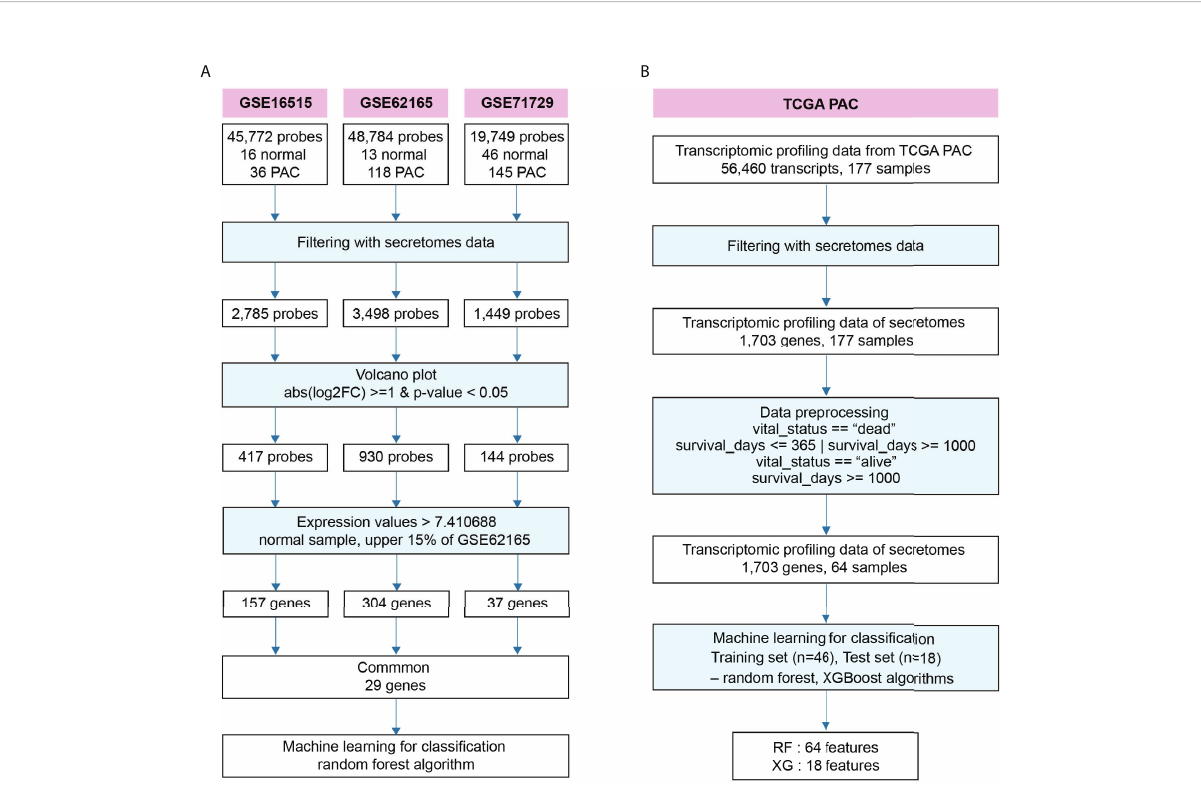
FIGURE 1 Schematic work fl ow to identify diagnostic and prognostic markers for pancreatic adenocarcinoma. (A) Work fl ow to identify prospective diagnostic markers from three independent transcriptomes. (B) Work fl ow to predict a putative prognostic marker from the transcriptome of pancreatic adenocarcinoma (PAC) at The Cancer Genome Atlas